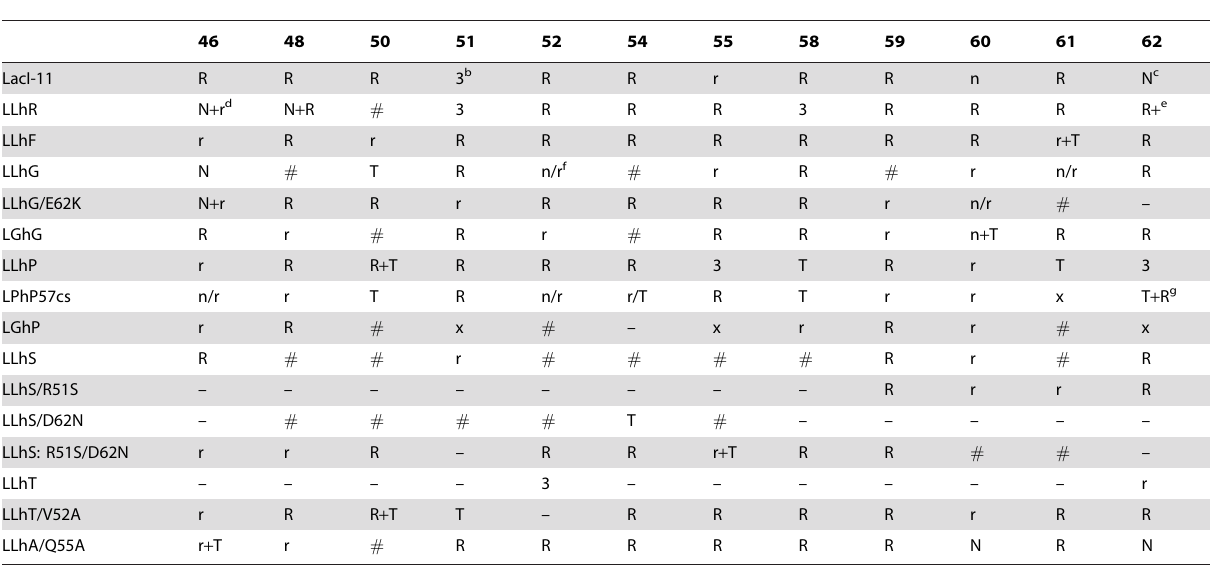
Table 4. Rheostat, toggle-like, and neutral behaviors of nonconserved linker positions a